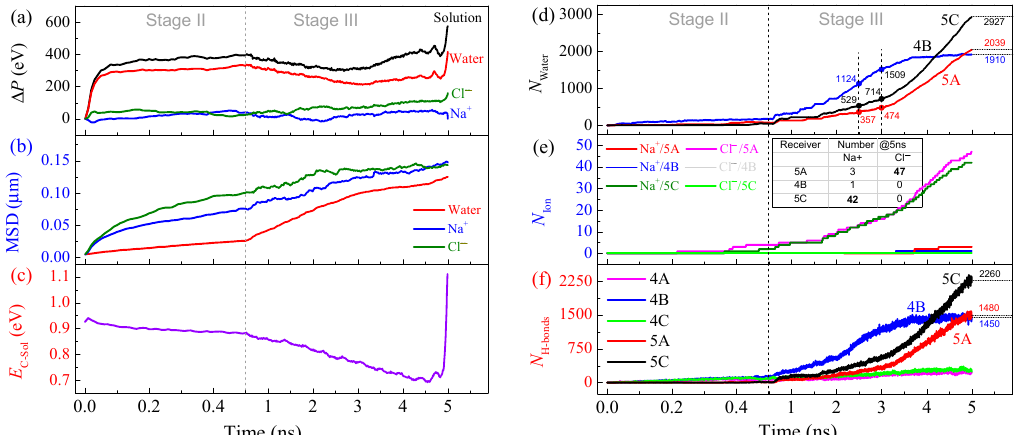
Figure 4. Physical quantities of the ion separation model with the A-30 CTT as subchannels at 300 K when E EF = 6.9 V/Å and C NaCl =0.6 mol/L NaCl. ( a ) VPE of the components in solution. ( b ) Mean square displacements (MSD) of the components. ( c ) Interaction energy between solution and the carbon frame. ( d ) The numbers of the water molecules in the three containers. ( e ) The numbers of ions in the three different subchannels and their connected containers. ( f ) The numbers of H-bonds in the three subchannels and their connected containers. In Figure 4d, the numbers of water molecules in the three containers ( Ω 5A , Ω 4B , and Ω 5C ) at the end of Stage II are much lower than those at the end of Stage III. It means that